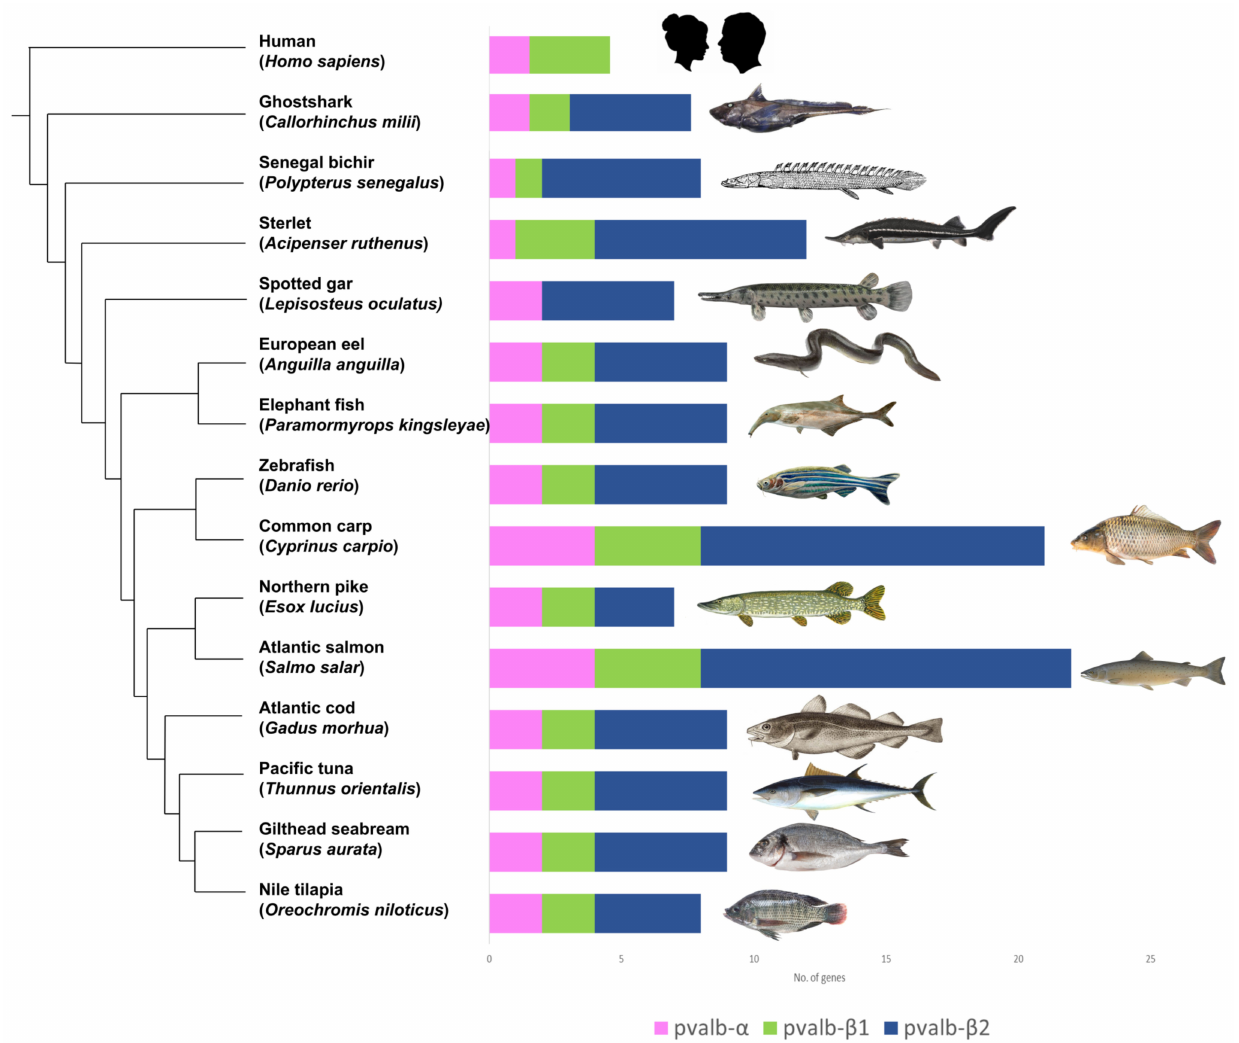
Figure 3. Phylogentic relation of parvalbumin in selected species of the teleost fishes and a non-teleost outgroup. Parvalbumin genes found in the selected fish genomes are shown in groups and coloured by the parvalbumin gene type, i.e., PVALB - α in pink, PVALB - β 1 in green, and PVALB - β 2 in blue The phylogenetic relation is according to the work of Mukherjee et al.